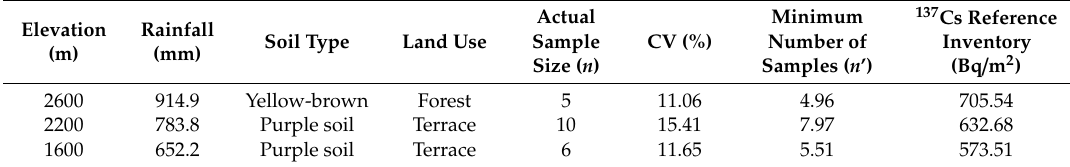
Table 1. The background of the 137 Cs reference inventory sampling location at di ff erent vertical zones. Elevation